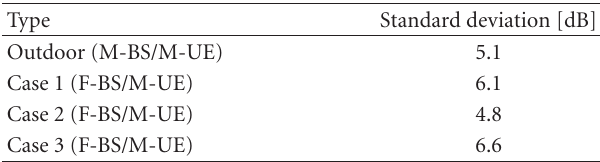
Table 2: Standard deviation of shadowing.